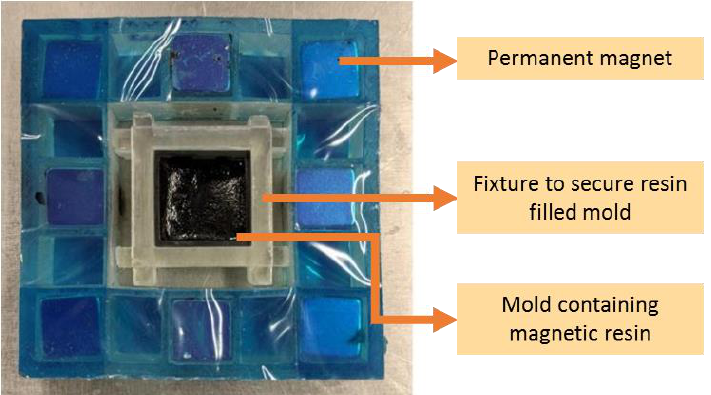
Figure 3. Magnetic alignment setup with permanent magnet array used to develop field structured magnetic composites.